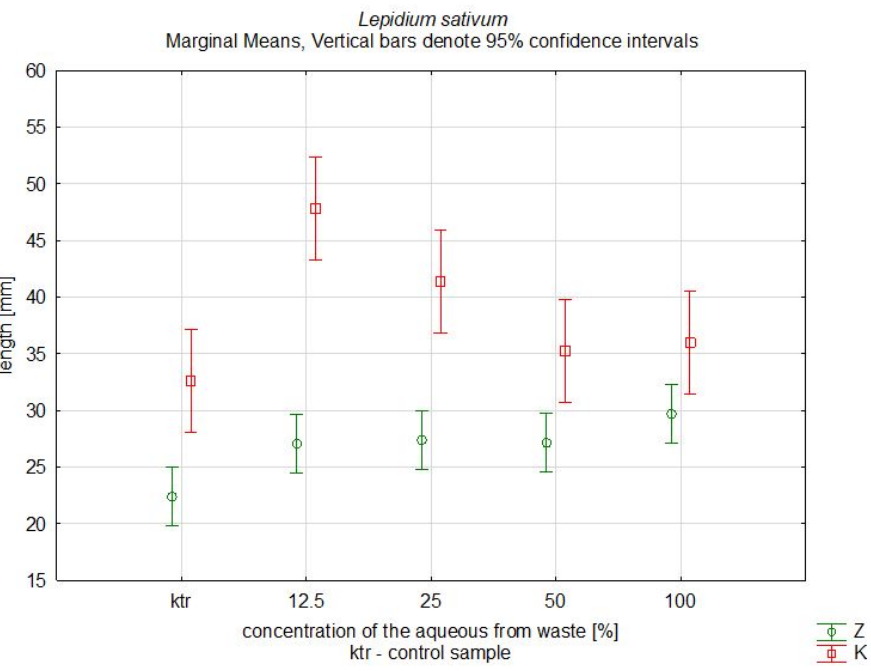
Figure 3. The growth of Lepidium sativum after 72 h of incubation of subsequent objects (for the studied concentrations).